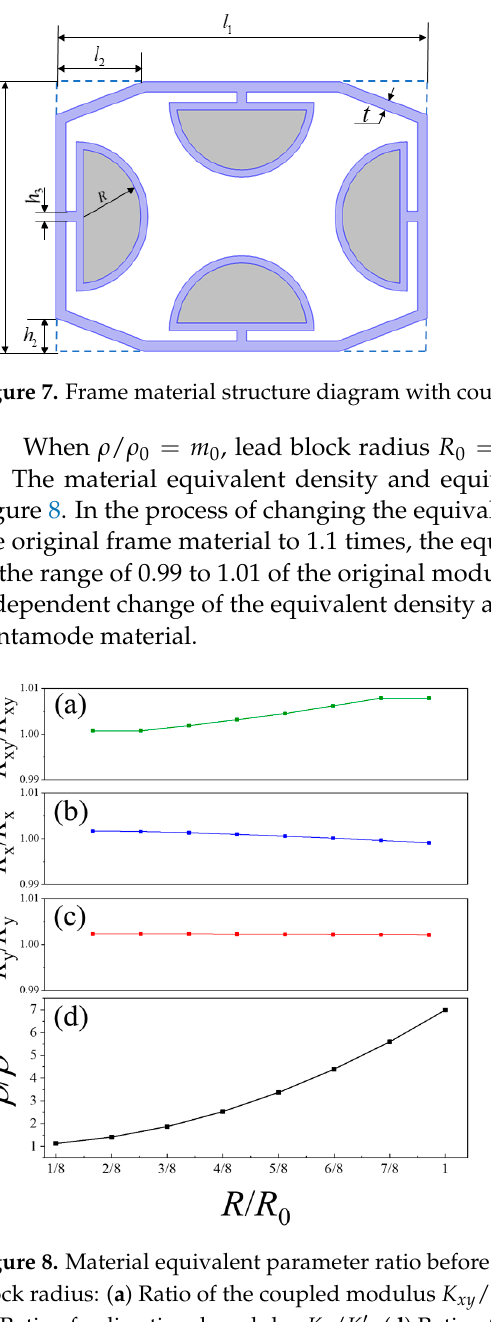
Figure 8. Material equivalent parameter ratio before and after adding mass blocks varies with lead block radius: ( a ) Ratio of the coupled modulus K xy / K (cid:48) xy ; ( b ) Ratio of x directional modulus K x / K (cid:48) x ; ( c ) Ratio of y directional modulus K y / K (cid:48) y ; ( d ) Ratio of density ρ / ρ (cid:48) .